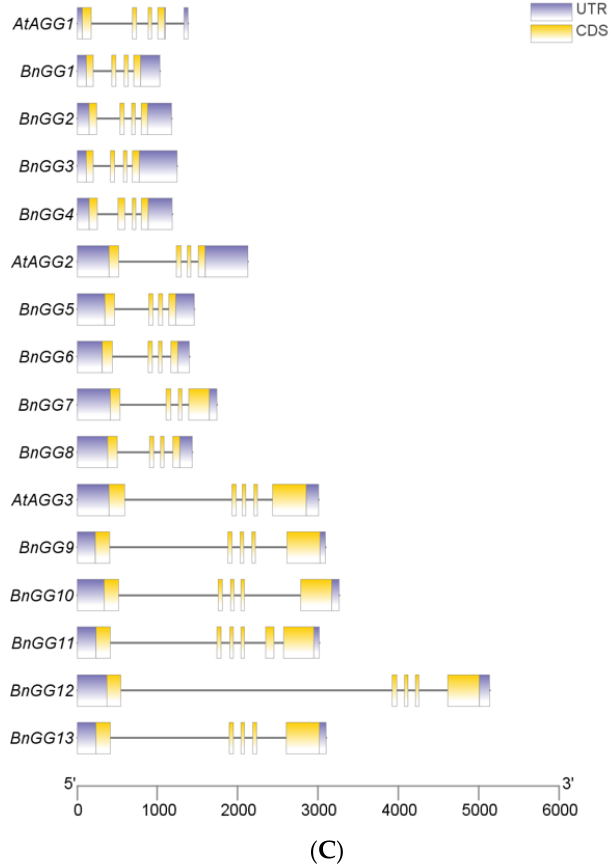
Figure 1. Gene structure analysis of G α ( A ) , G β ( B ), and G γ ( C ) genes between A. thaliana and B. napus . Yellow boxes represent exons and black lines represent introns. The upstream/downstream region of G-protein genes are indicated in purple boxes. The length of exons can be inferred by the scale at the bottom.